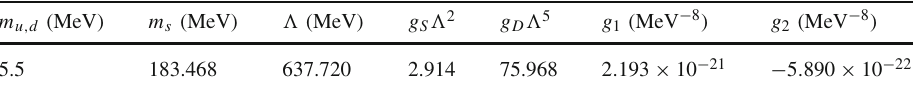
Table 4 Parameters for the NJL part in the realistic PNJL model